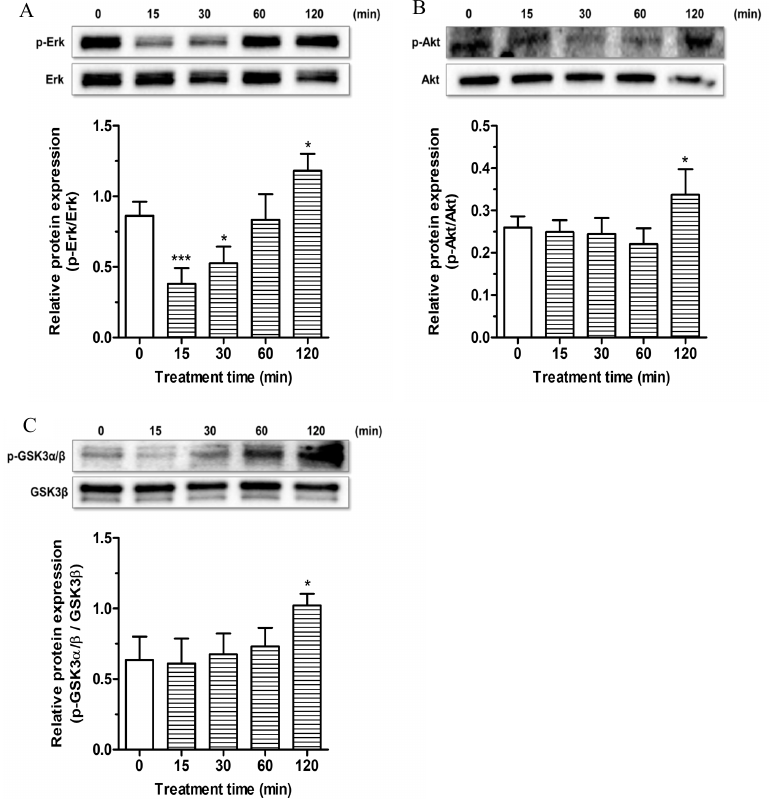
Figure 7. Effects of ESC on survival kinase pathways in SH-SY5Y cells. Cells were treated with ESC (20 μ M) for different times. At the end of treatment, the phosphorylation of Erk, Akt and GSK3 α / β kinase levels was measured by Western blotting. Data are expressed as the ratio between phosphorylated form and total protein expression and reported as mean ± SD of three independent experiments (* p < 0.05 and *** p < 0.001 vs. untreated cells at one-way ANOVA with Dunnett post-hoc test).